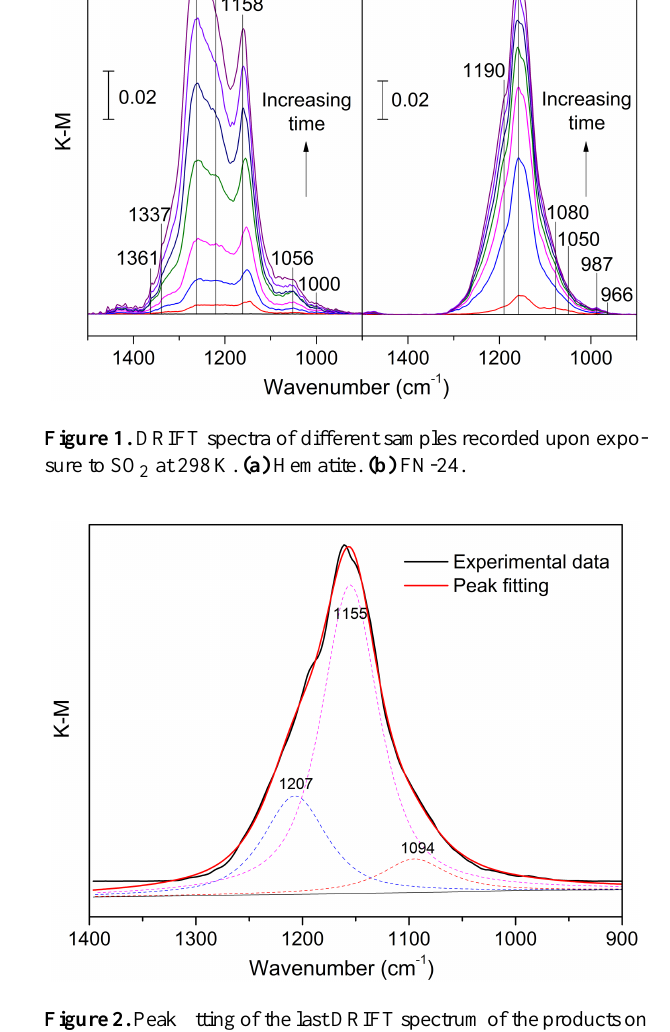
Figure 2. Peak fitting of the last DRIFT spectrum of the products on FN-24 shown in Fig. 1 by mixed Gaussian–Lorentzian peak